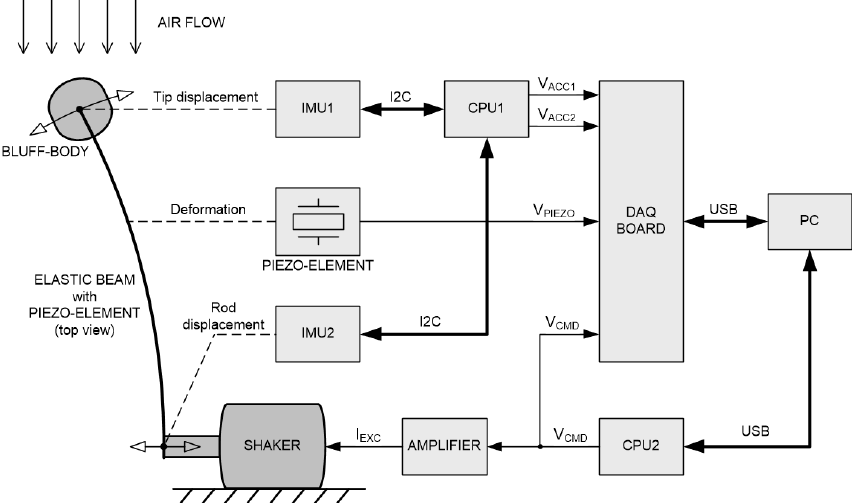
Figure 4. Diagram of the measuring system.